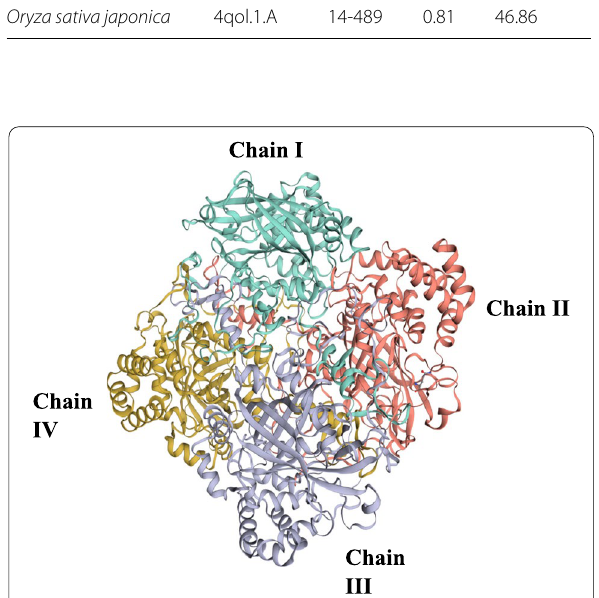
Fig. 3 Predicted protein model of catalase enzyme of Arabidopsis thaliana showing distinct four homo-tetrameric